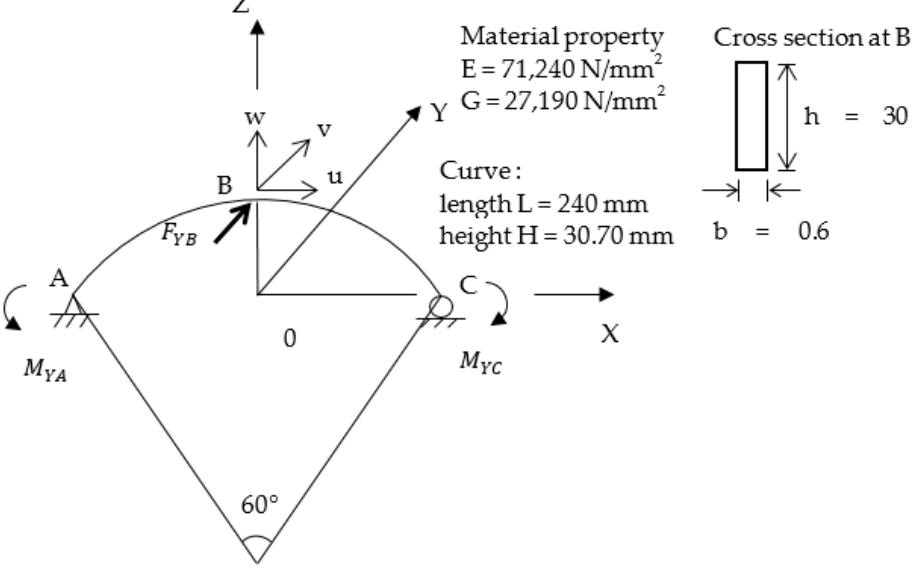
Figure 16. Curved beam subject to the end moment.